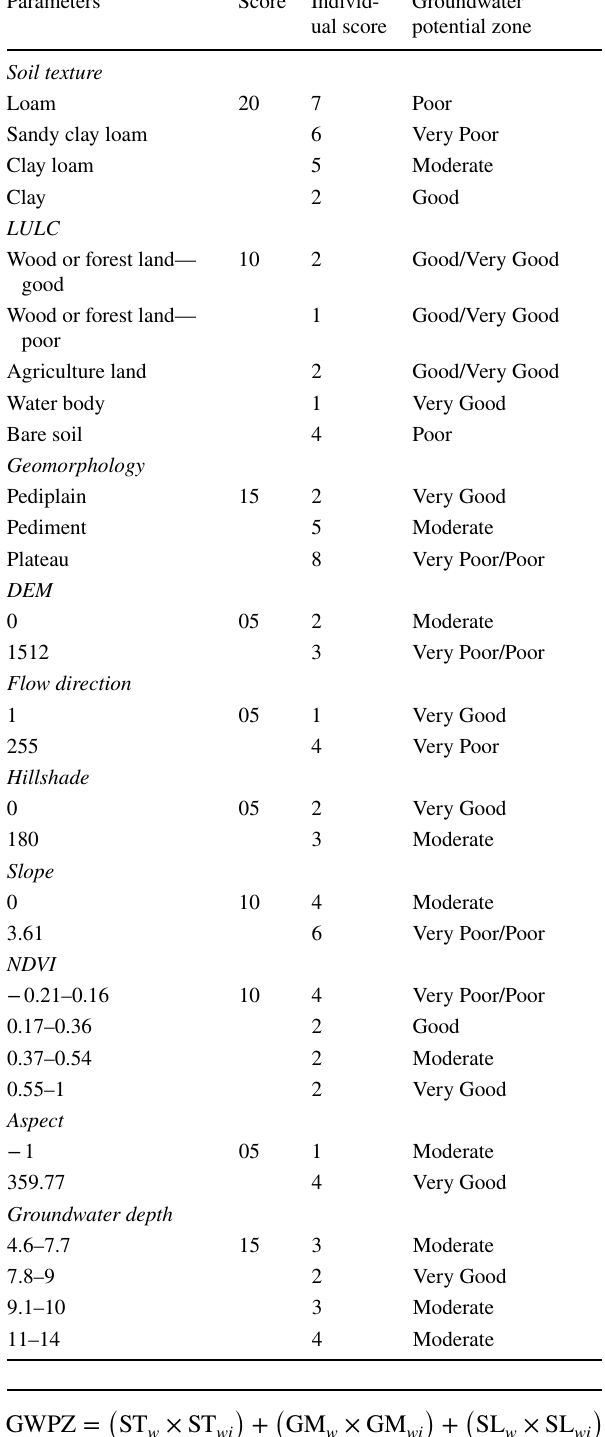
Table 5 Assigned score and individual score of every thematic layer for GPZ